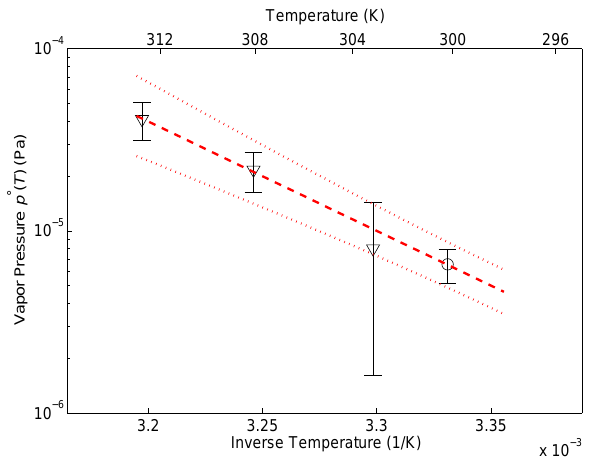
Fig. 4. Pure component vapor pressure p ◦ ,L of 2-hydroxymalonic acid (open symbols, denoting two different particles). Fit line (dashed) is to Eq. (5) with 2 σ error bounds shown as dotted lines. retrieve pressures of 1 × 10 − 6 Pa and lower. The calculated p ◦ ,L (T (cid:9) ) of ( 1 . 0 ± 0 . 2 ) × 10 − 3 Pa agrees very well with the value reported by Booth et al. (2010).